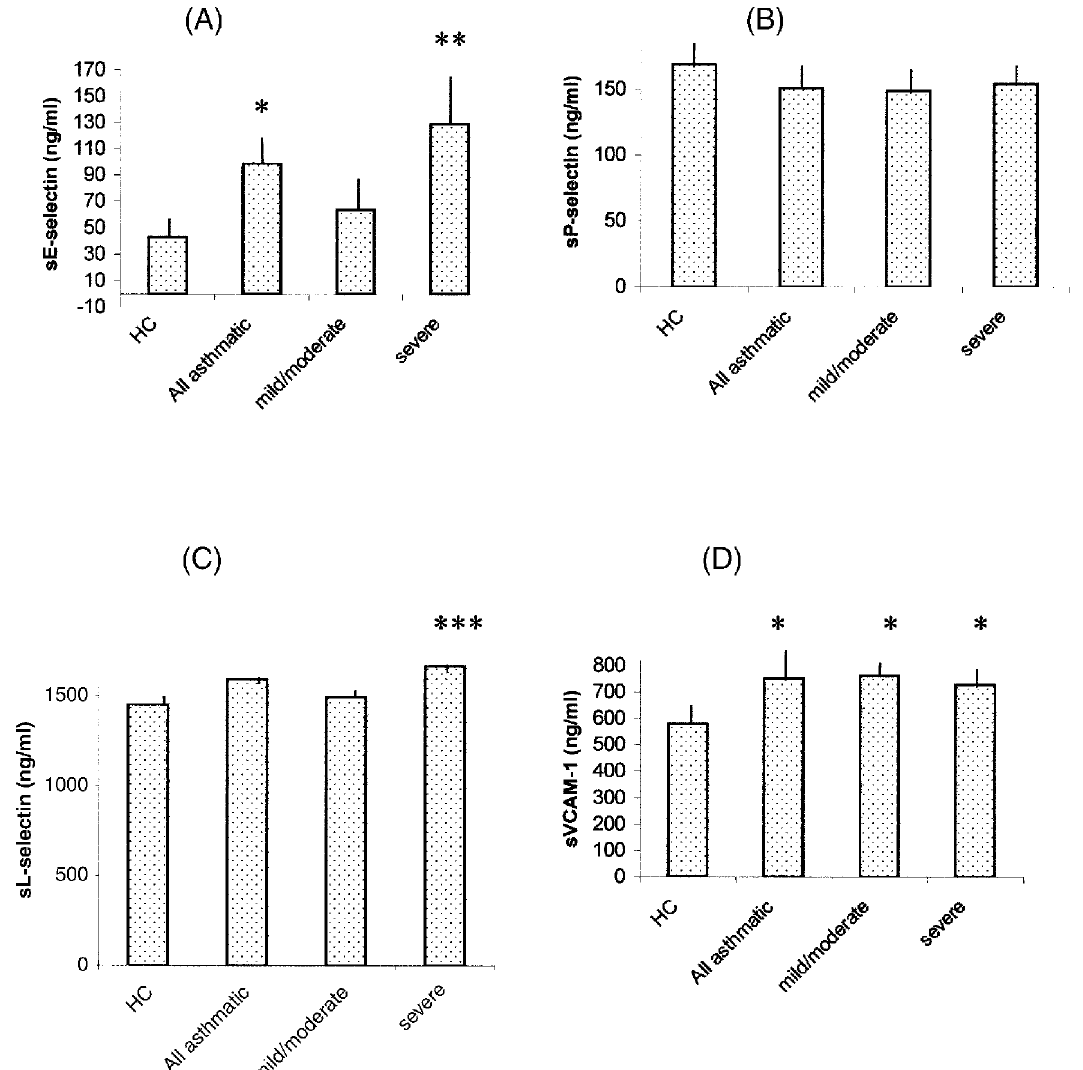
FIG. 1. Expression of (A) sE-selectin, (B) sP-selectin, (C) sL-selectin and (D) sVCAM-1 in female asthma patients and in healthy controls (HC). Patients were selected in the mild/moderate asthma group and the severe asthma group. * Significantly different when compared with healthy controls ( p < 0.01), ** significantly different when compared with all asmathic patients and with patients with mild/moderate asthma ( p < 0.001), and *** significantly different when compared with patients with mild/ moderate asthma ( p <